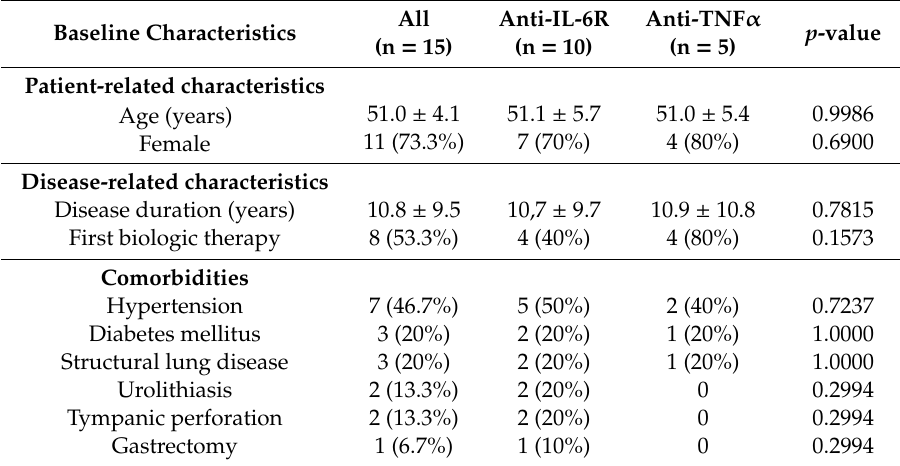
Table 1. Baseline characteristics.